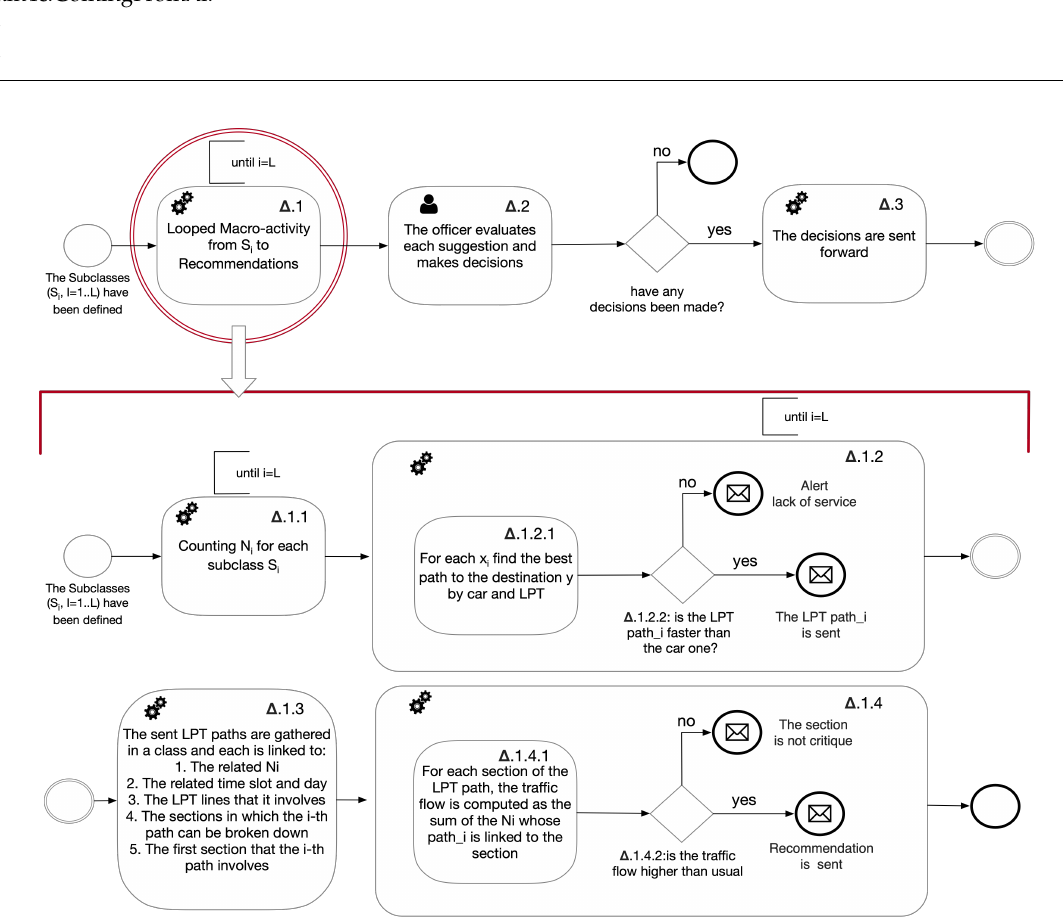
Figure 11. The decision making process ∆ for the case